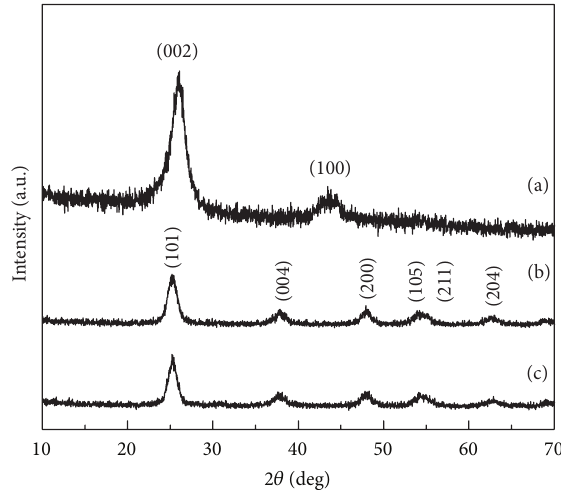
Figure 1: XRD patterns of bare CNx (a) and TiO 2 -CNx composites with different weight ratio of TiO 2 over CNx 5% (b) and 20%